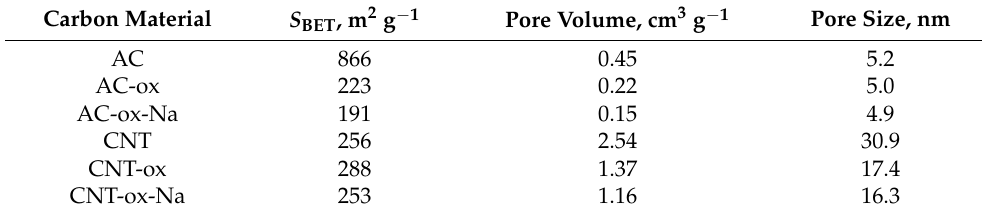
Table 1. Characterization of carbon materials using BET